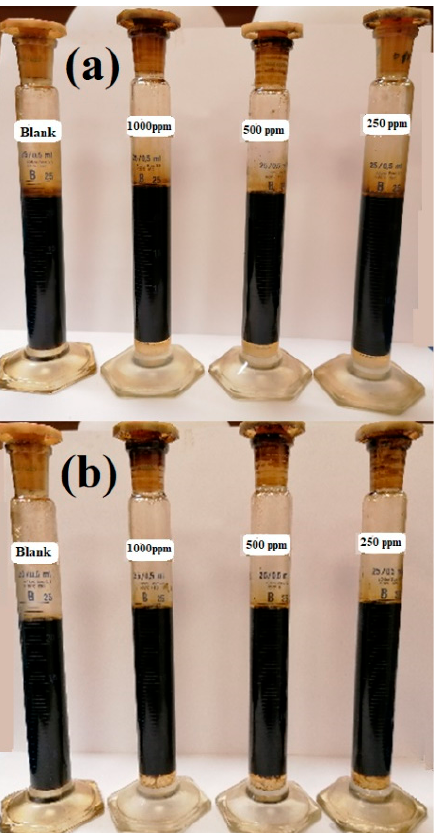
Figure 7. Optical images of cylinders exhibiting separated water in W/O emulsions (volumetric ratio 90:10) using ( a ) ATEI-IL and ( b ) ATHI-IL .